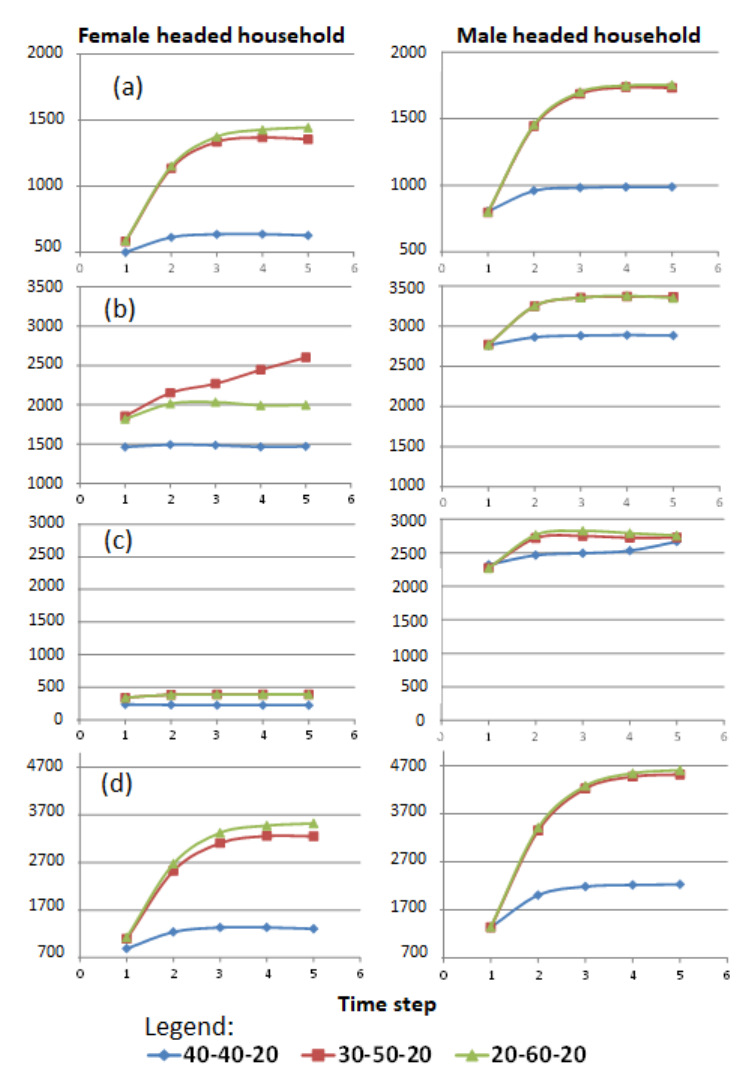
Figure 5. Average annual crop yields for teff ( a ), sorghum ( b ), millet ( c ), and wheat ( d ) by gender of household head under different labor allocations and normal population growth (2.5%).